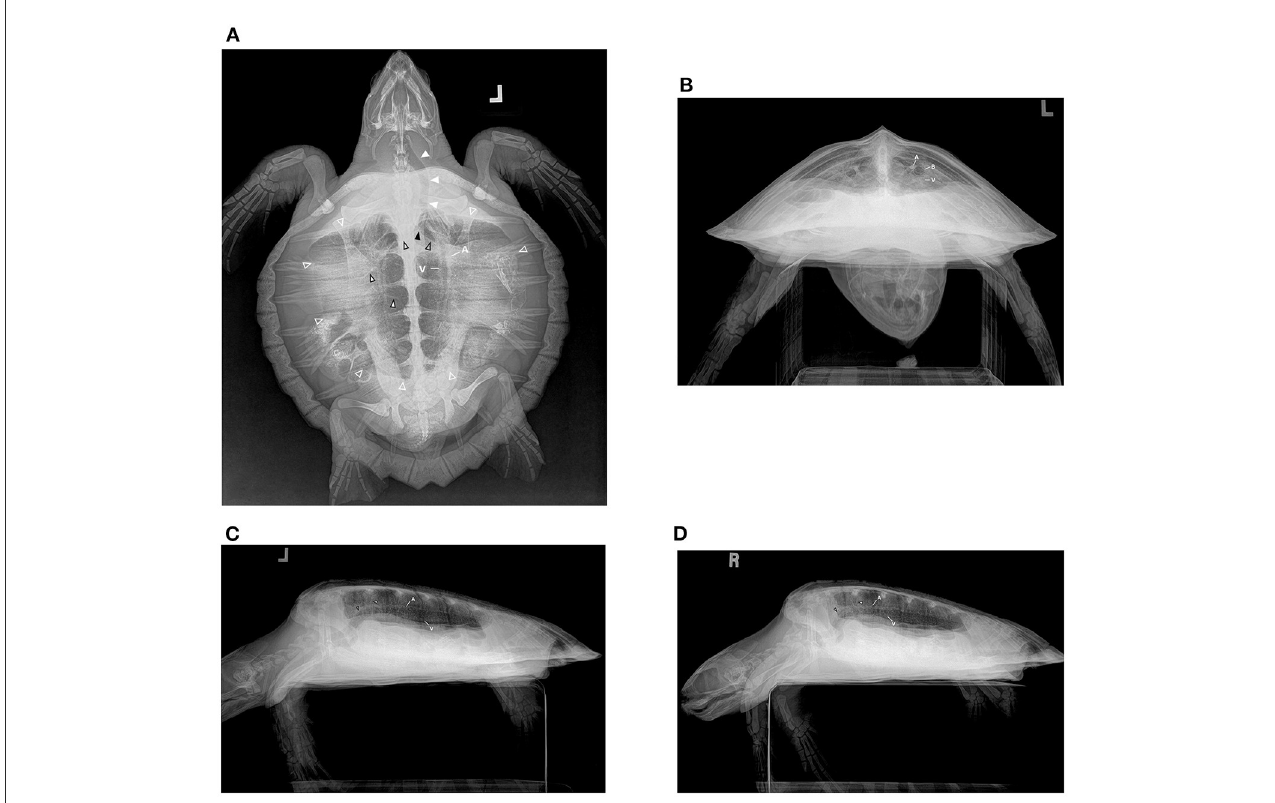
FIGURE2 Radiograph series in a hook-and-line capture but otherwise healthy juvenile Kemp’s ridley sea turtle ( Lepidochelys kempii ). (A) Dorsoventral (DV) projection: The trachea is seen left of midline (solid white arrows) in the cervical region before bifurcating (solid black arrow) in the cranial central coelom into the right and left main bronchus (black outlined hollow arrows). The main bronchus is seen coursing from cranial to caudal in the medial lung field as horizontal soft tissue opaque striations of branching channels (black outlined white arrows) are observed coursing from the mainstem bronchus to the periphery perpendicular to the main bronchus. The lung field is seen (while outlined hollow arrows); however, superimposition of gastrointestinal ingesta and gas present within the gastrointestinal tract limits the full assessment of some regions. The pulmonary artery (A) and pulmonary vein (V) can be seen in parallel coursing through the lung on either side of the bronchus. (B) Rostrocaudal (RoCd) projection: Both lung fields are relatively symmetric making up ∼ 30% of the coelomic cavity. The mainstem bronchus (B) is evident in each central lung represented by a thin-walled radiopaque circular structure that is radiolucent in the center. The pulmonary arteries (A) can be seen just dorsal to the main bronchus. Less evident are the pulmonary veins (V) ventral to the main bronchus. (C) Left and (D) Right Lateral Projection: The lung margins are smooth, and the lung fields occupy ∼ 40 ± 10% of the coelomic cavity. The main bronchus (black outlined hollow arrow) is end-on and is seen coursing from cranial to caudal, horizontally through the ventral lung field. There are vertical striations (black outlined white arrow) through the lungs on these views that reflect the channels that branch from the main bronchus. The pulmonary arteries (A) are dorsal to the main bronchus and the pulmonary veins (V) are ventral, both seen slightly obliquely in this